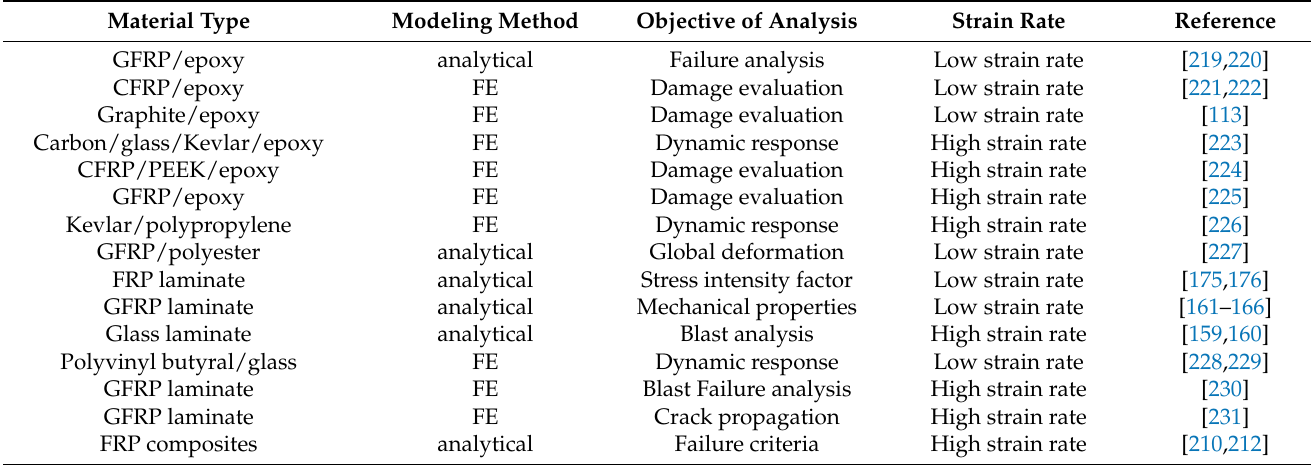
Table 4. Rate-dependent theoretical models developed in FE